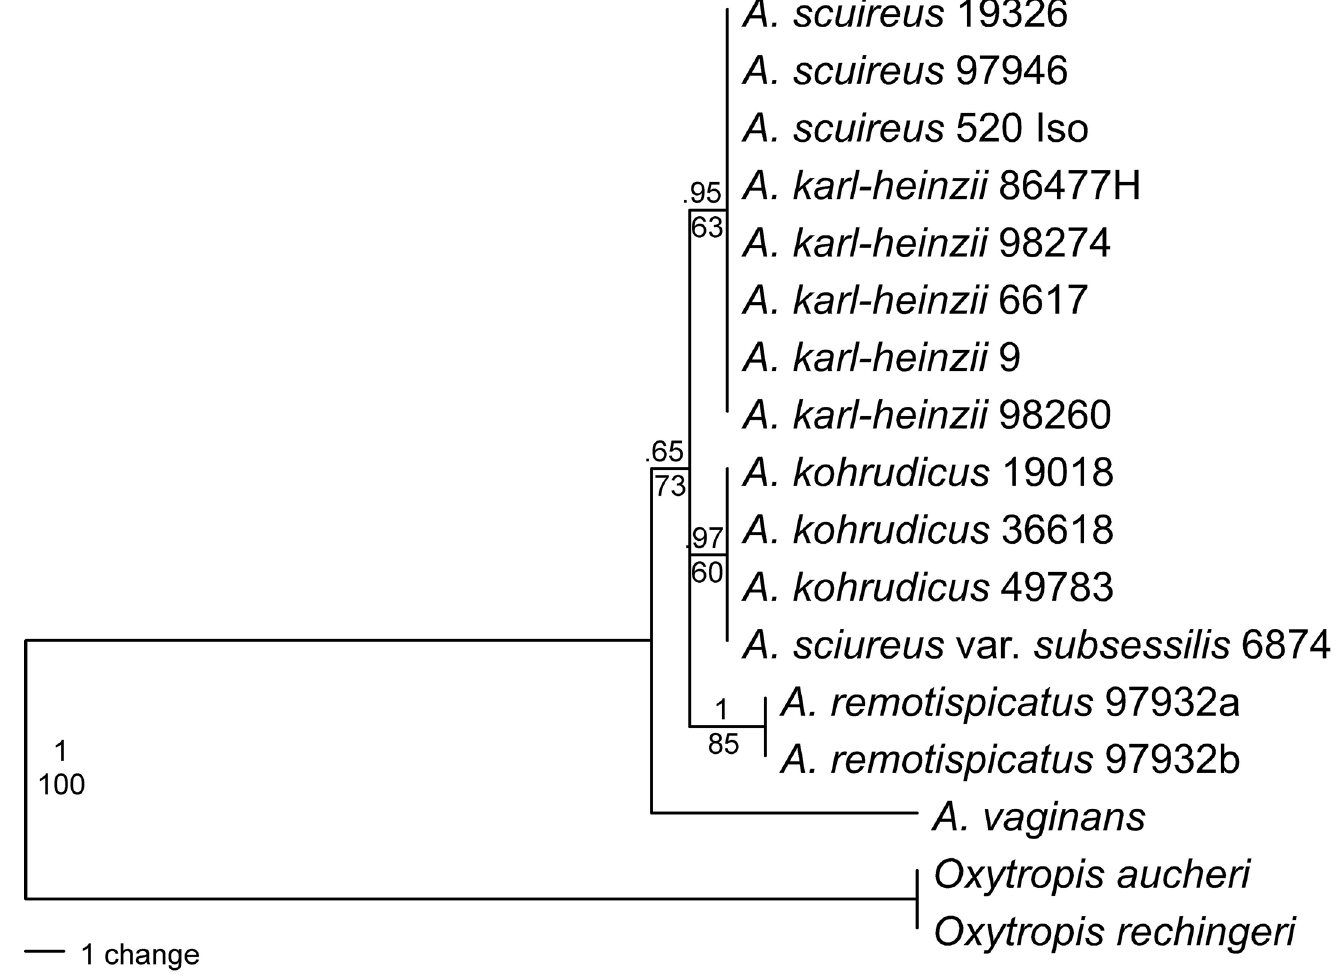
Fig 4. Single most parsimonious tree (tree length = 52 steps, consistency index = 1) derived from a phylogenetic analysis of sequence data of the nuclear ITS region. An identical tree topology was obtained with Bayesian phylogenetic inference. Numbers above branches indicate posterior probabilities of the Bayesian analysis, below the bootstrap values (%) for the parsimony analysis are